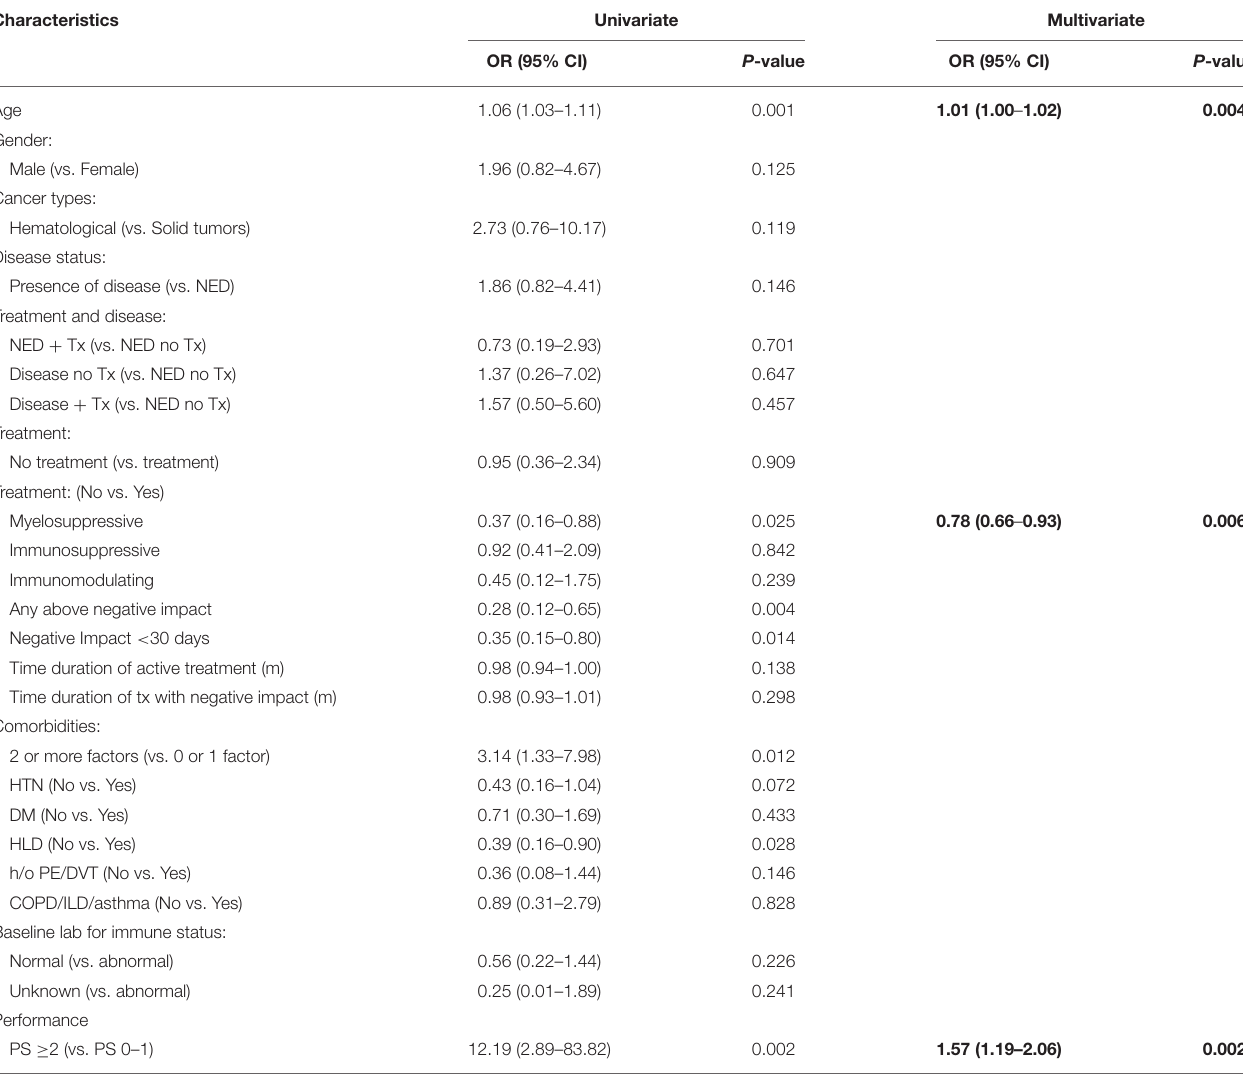
TABLE 5 | Multivariate logistic regression analysis on risk factors associated with a more severe status of SARS-CoV-2 infection: group A + B (hospitalized patients) vs. group C + D (home recovery patients).